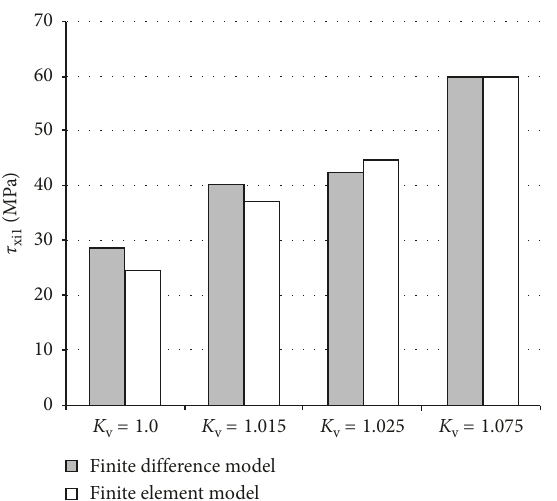
Finite difference model Figure 20: Comparative analysis of the calculated values of tan- gential contact stresses obtained using the proposed finite differ- ence and finite element models.